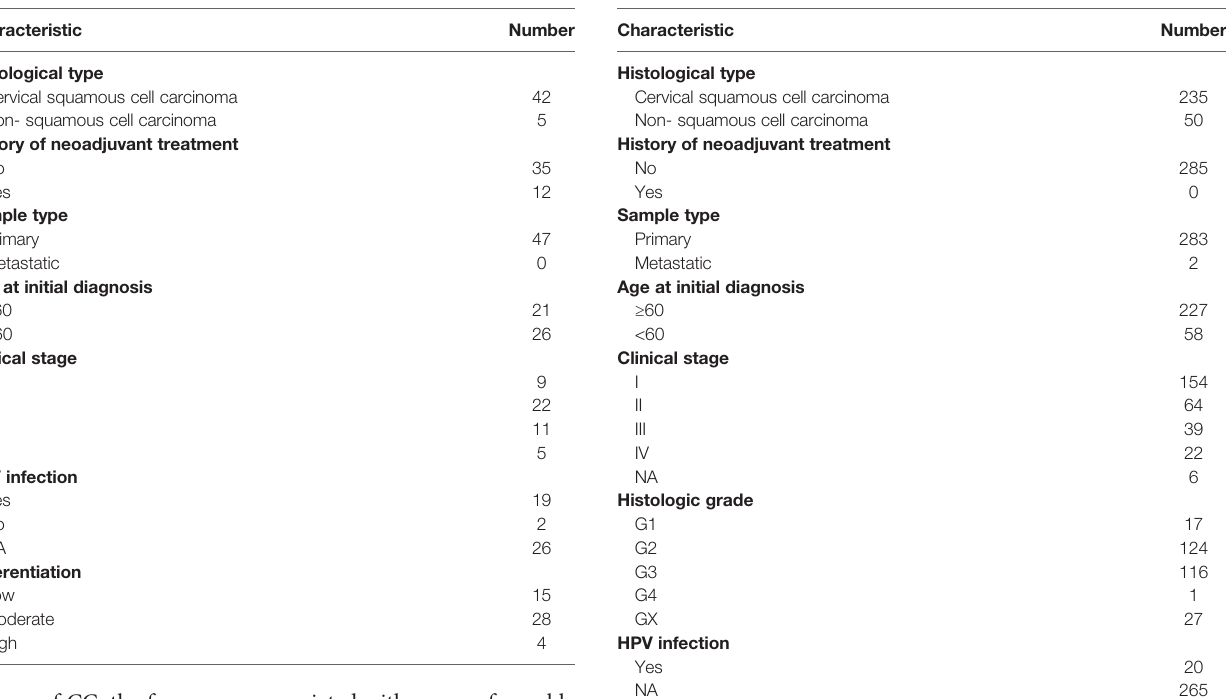
TABLE 2 | Clinicopathological parameters of patients with cervical cancer in TCGA dataset in the study.